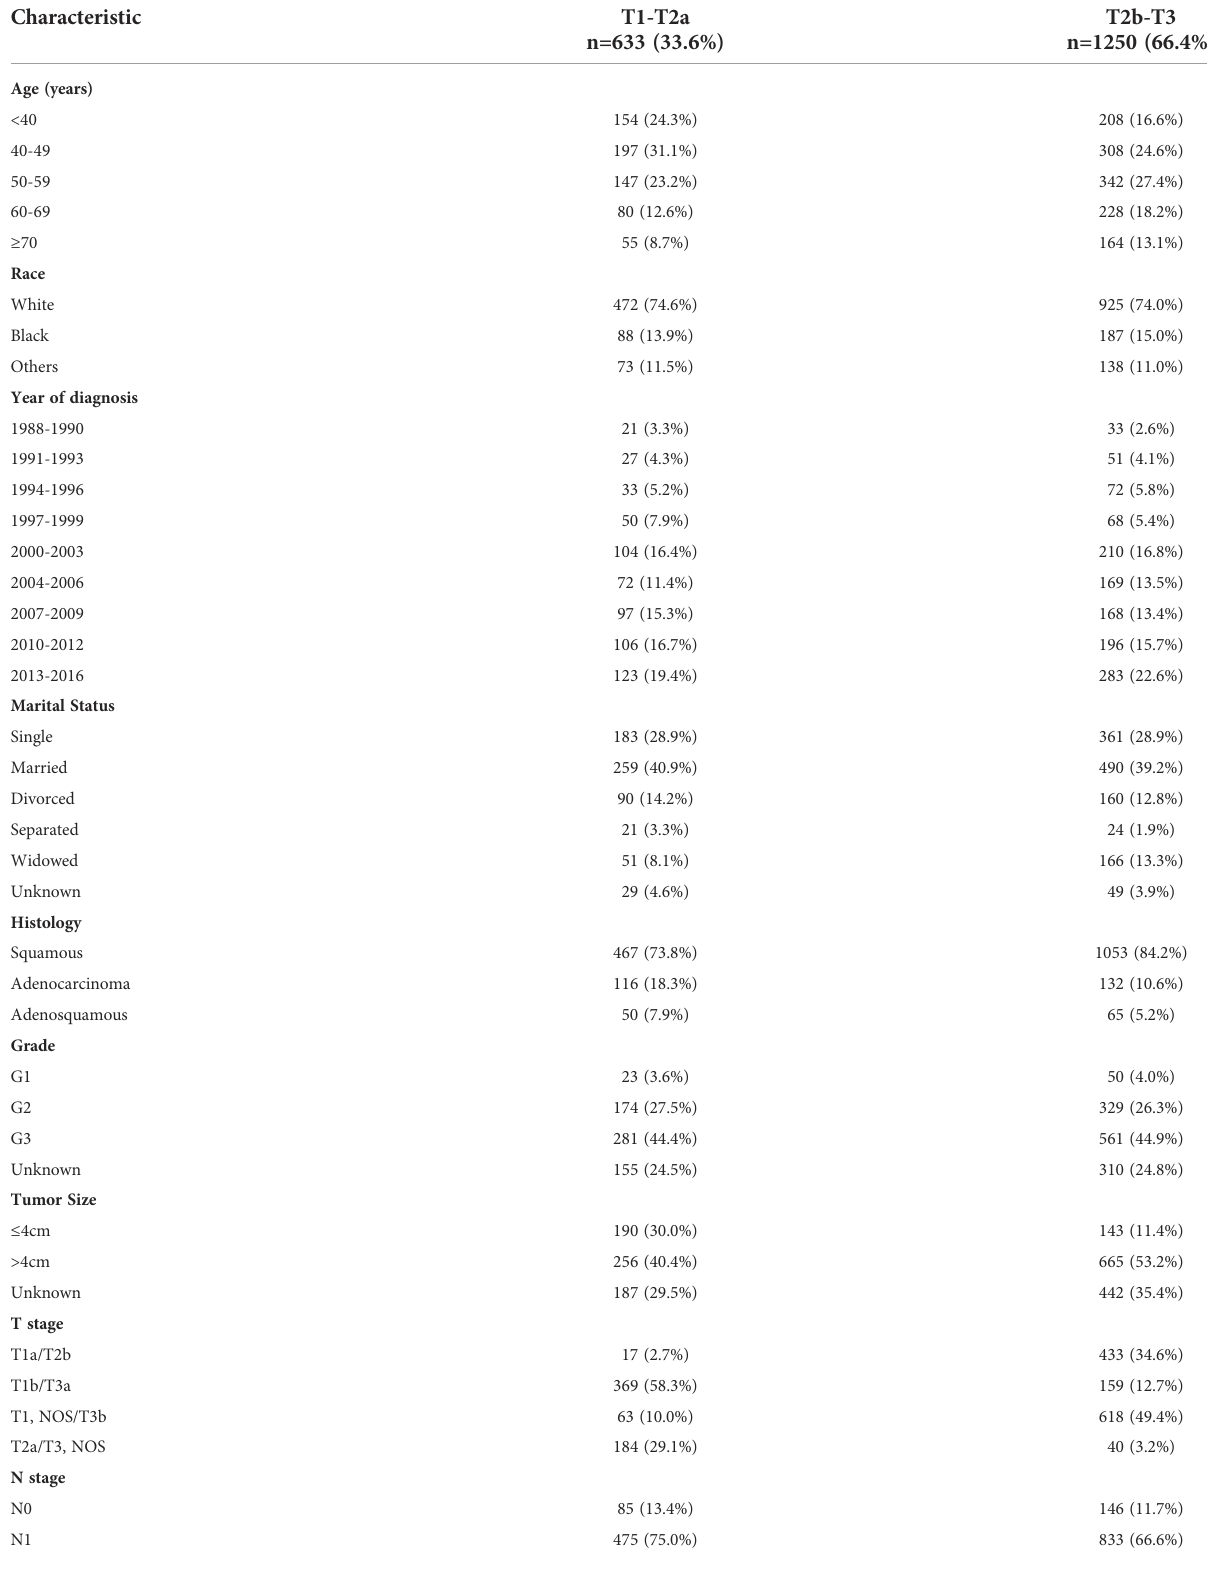
TABLE 2 Demographics and clinical characteristics of patients with distant lymph node